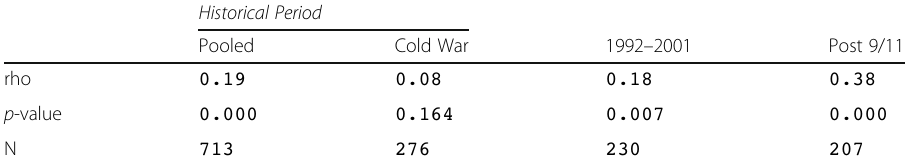
Table 3 How IRO-CRI cross-sectional correlations increase over time Historical